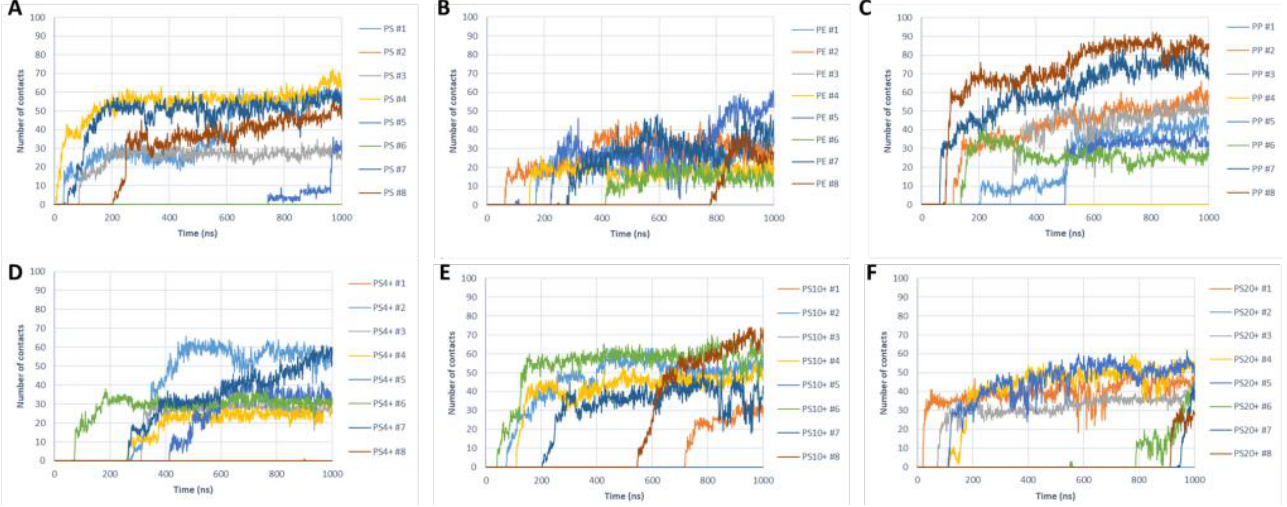
Figure 3. Number of contacts as a function of time. The plots show the number of amino acids in 230 contact with the NPs for nanoparticles made of ( A ) PS; ( B ) PE; ( C ) PP; and positively charged PS 231 nanoparticles with a charge density of ( D ) 4%, ( E ) 10%, and ( F ) 20%. For the negatively charged 232 NPs, we did not observe interactions during the MD simulations. Table 1. Type of contact for the different NP – fibril